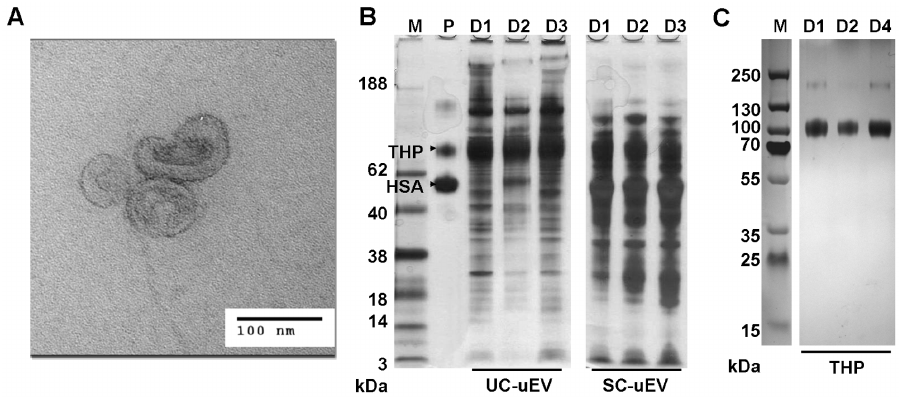
Figure 1. Evaluation of uEVs enriched by UC and SC methods. ( A ) TEM image of representative UC-uEVs. ( B ) Migration of 1 m g THP and 1 m g human serum albumin (HSA, lane P) compared to 5 m g total UC- and SC-uEV protein profiles from 3 healthy donors (lanes D1, D2 and D3). ( C ) 4–20% Bis-Tris SDS-PAGE of 2 m g THP isolated from three healthy donors (lanes D1, D2, and D4). Lane M represents M r standard and gels were stained with silver. Data is representative of outcomes from a minimum of 10 individual uEV enrichment experiments for each method.